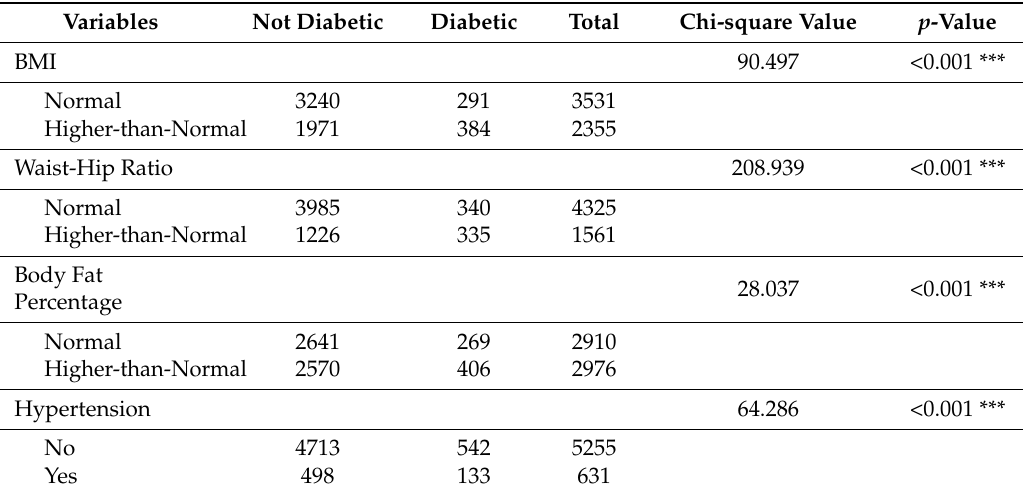
Table 3. Correlation of Each Health Exam Variable and Having Diabetes.